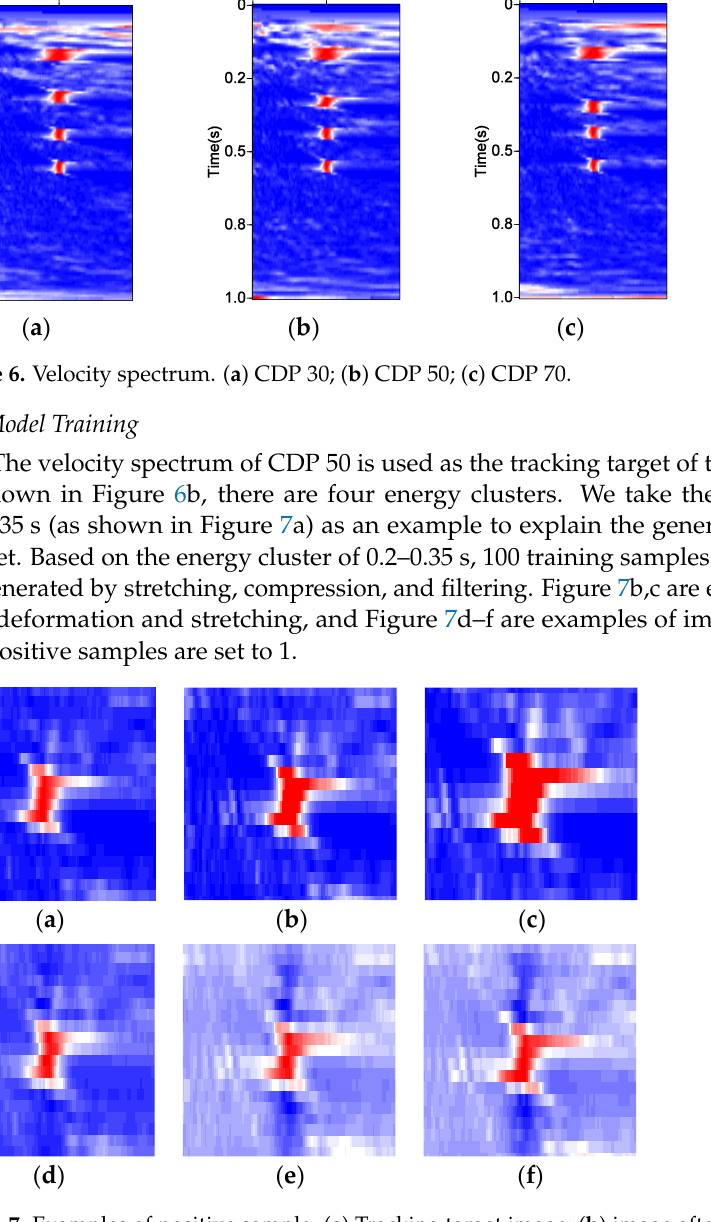
( c ) image after 3 times stretching; ( d ) image after low-pass filtering; ( e ) image after bandpass filtering; ( f ) image after high pass filtering.